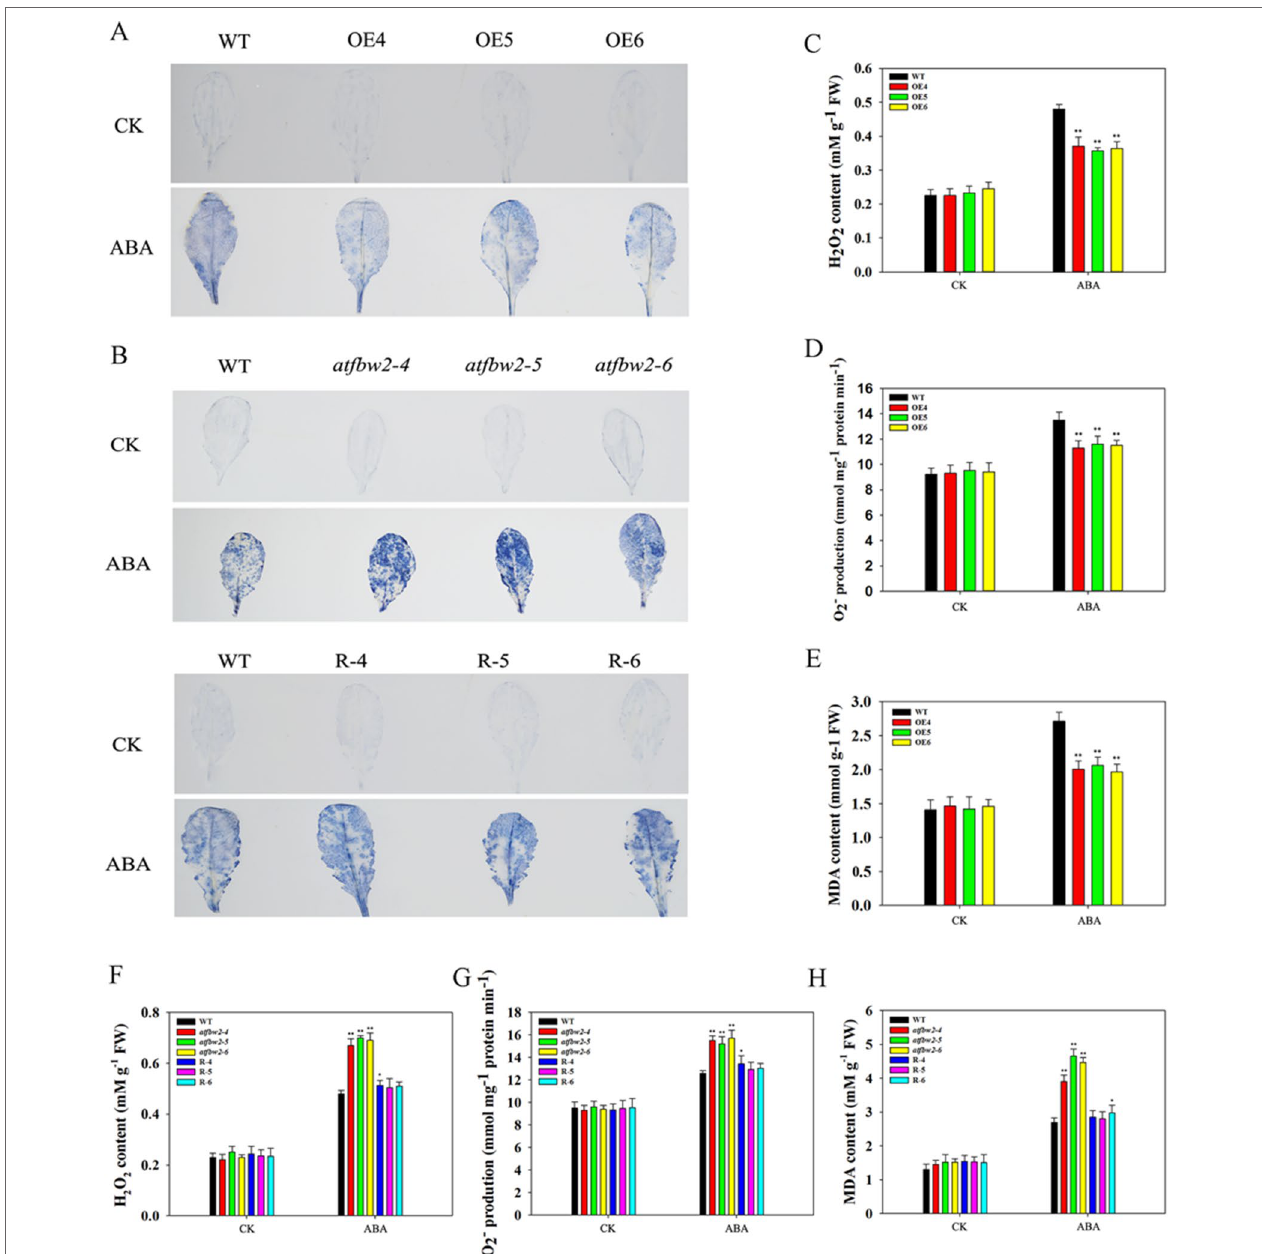
FIGURE 12 | ROS accumulations and MDA content in Arabidopsis plants following ABA treatment. O 2− accumulations were detected by histochemical staining using NBT in the leaves of (A) WT and OEs (OE4, OE5, OE6) plants, as well as in (B) WT, mutant ( atfbw2-4 , atfbw2-5, atfbw2-6 ) and recovery (R-4, R-5, R-6) Arabidopsis plants. Quantitative analysis of O 2- (D , G) and H 2 O 2 (C , F) were also conducted. MDA contents in (E) WT and TaFBA1-overexpression lines (OE4, OE5, OE6). (H) MDA contents in WT, mutant ( atfbw2-4 , atfbw2-5 , atfbw2-6 ) and recovery plants (R-4, R-5, R-6). Data represent mean ± SE of three biological replicates. * P < 0.05; ** P <